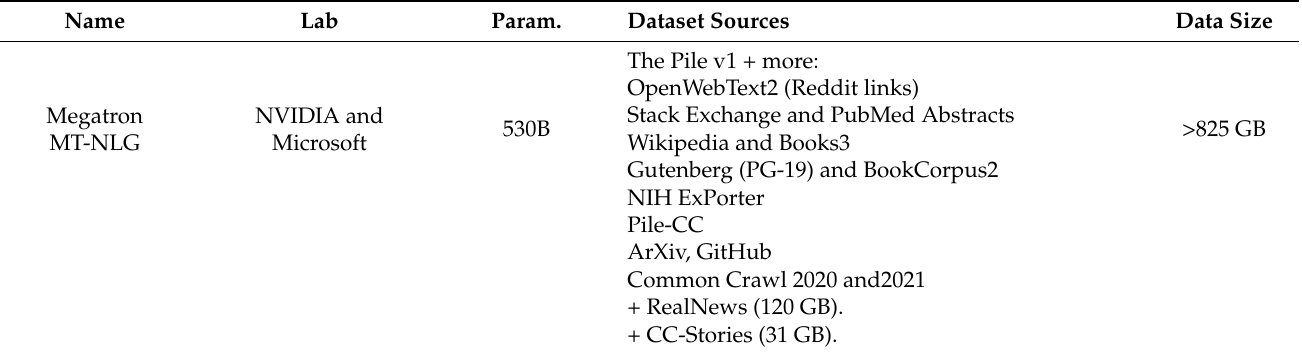
Table 2. Summary of major datasets used in pre-training language